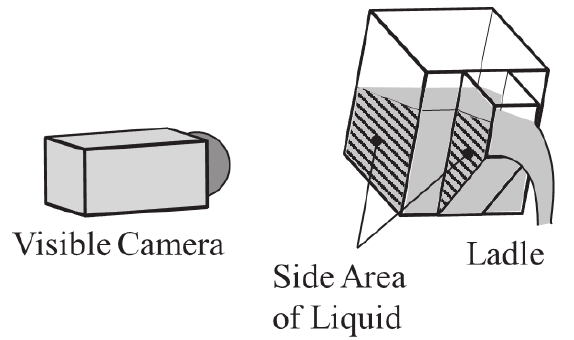
Figure 14. Measurement of side area of liquid in